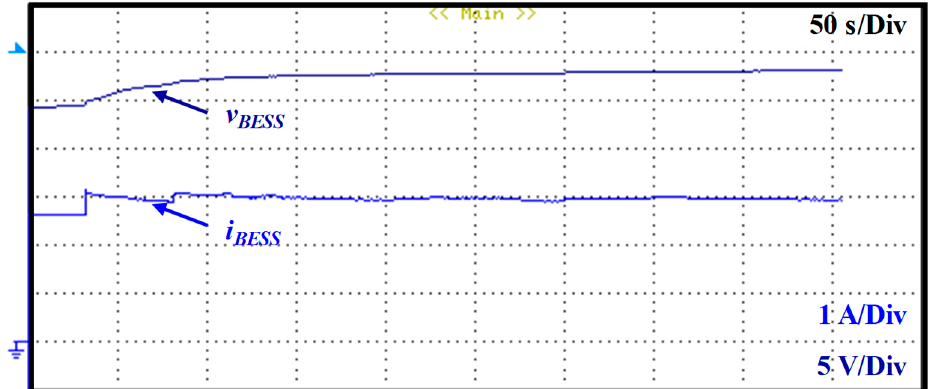
Figure 18. Experimental results of the developed multifunctional isolated microinverter: Voltage ( v BESS ) and current ( i BESS ) of the BESS during the charging process.